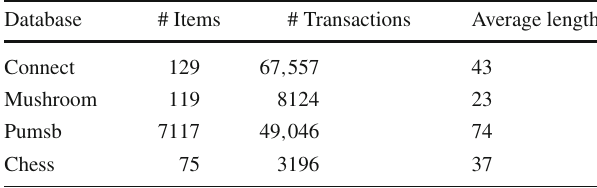
( s , s , c , c ) , ⊆ R 0 1 0 1 1 1